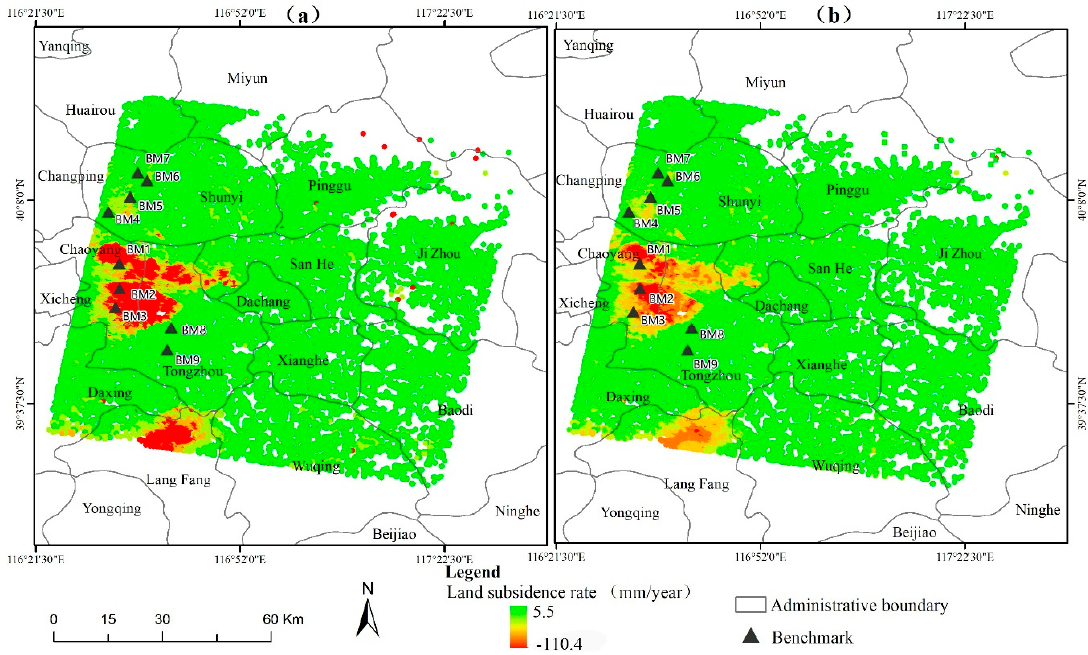
Figure 11. PS coherence coefficients for PS-InSAR and PS-InSAR+RELAX.